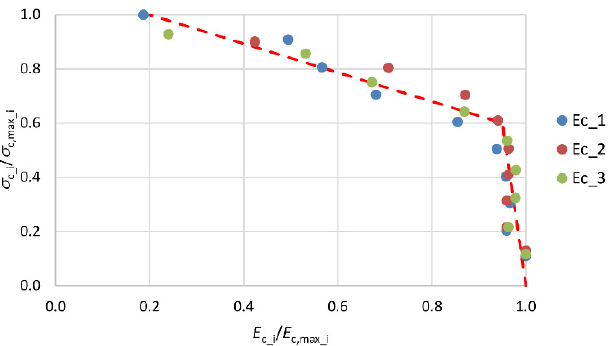
Figure 4. Character of change in secant elasticity modulus values as stresses in concrete increase (i—number of sample; i = 1, i = 2, i = 3).